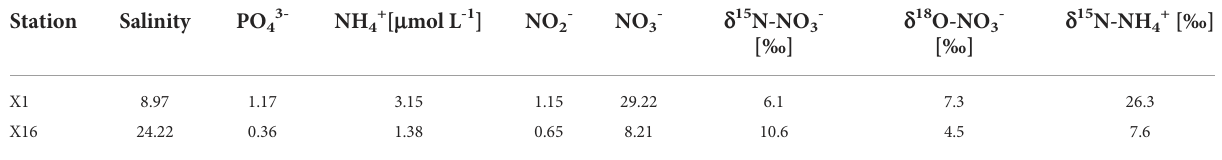
TABLE 1 The hydrological characteristics, nutrient concentrations and isotopic values of freshwater and marine endmembers of Xi Bay.